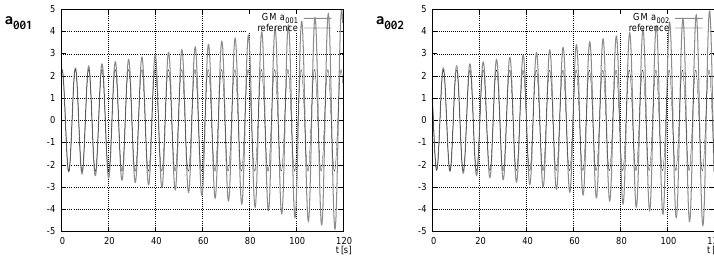
Figure 9. Uncalibrated two-equation Galerkin model compared with Direct Numerical